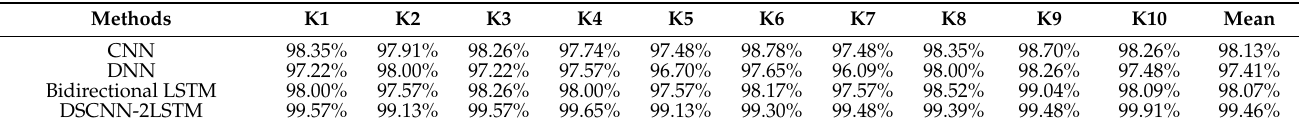
Figure 6. Iterative training time of DSCNN-2LSTM and other models on the five-class classification task. Table 11. The Performance of 11 models using 10-fold cross-validation on the binary classifica- tion